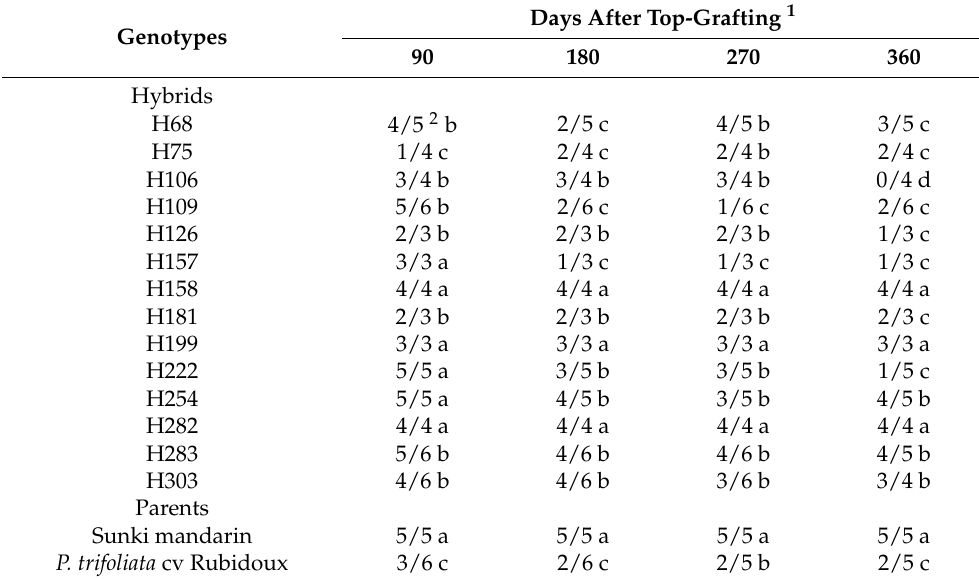
Table 2. Number of C Las-infected shoots from citrandarins and parents top-grafted onto HLB- diseased Valencia